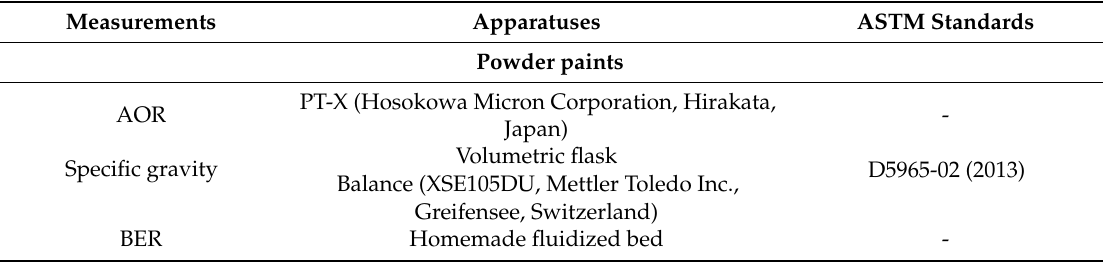
Table 5. Measurements of powder paints and coating